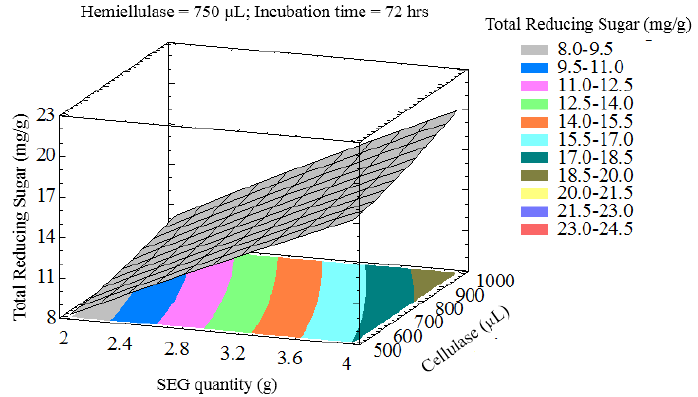
Figure 1. Three-dimensional response surface plot showing influence of cellulase (uL) and incubation time (h) when the response surface is fixed at a spent espresso grounds (SEG) quantity = 3 g and hemicellulase = 750 uL.